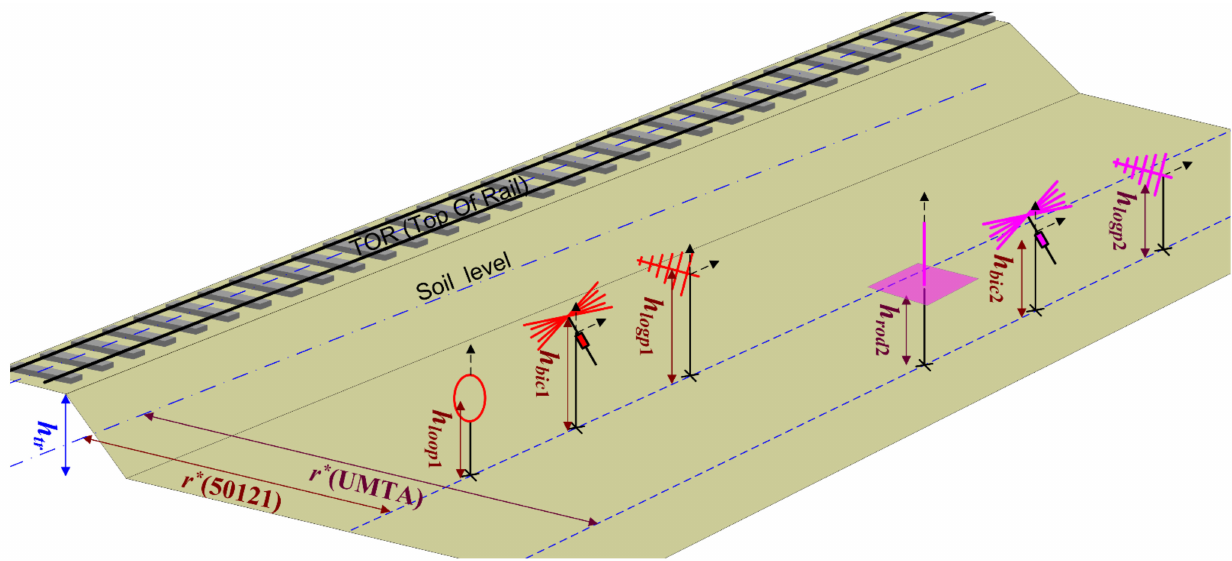
Figure 3. Sketch of antenna orientations as per EN 50121 (red) and Urban Mass Transport Association (UMTA) (pink): h loop 1 = 1.5–2.5 m, h bic 1 = 2.5–3.5 m, h logp 1 = 2.5–3.5 m, and h rod 2 = h bic 2 = h logp 2 = 2.0 m; orientation indicated by